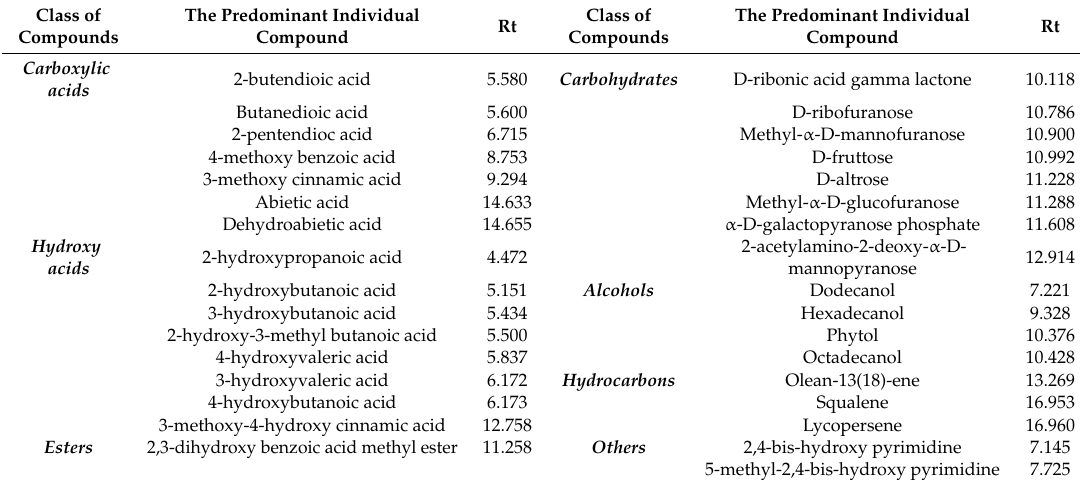
Table 4. The main class of organic compounds identified in the extracts of bioglea. Class of